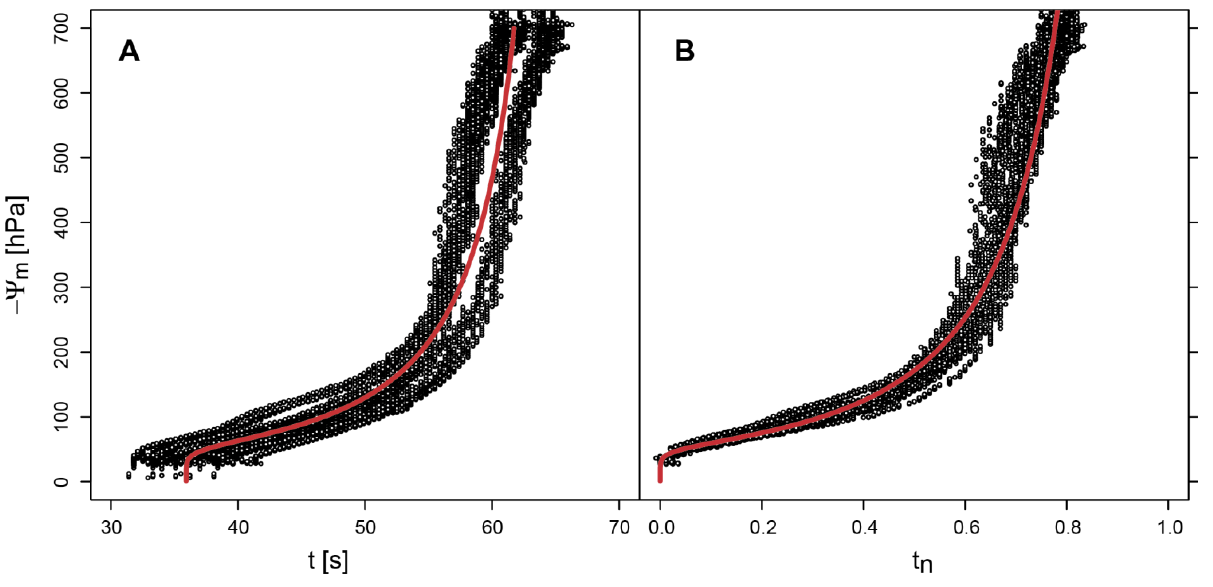
Figure 3. Calibration of the signals of 7 sensors with simultaneous tensiometer readings expressed as absolute cooling time t fitted with Equation (3) ( A ) and as normalized